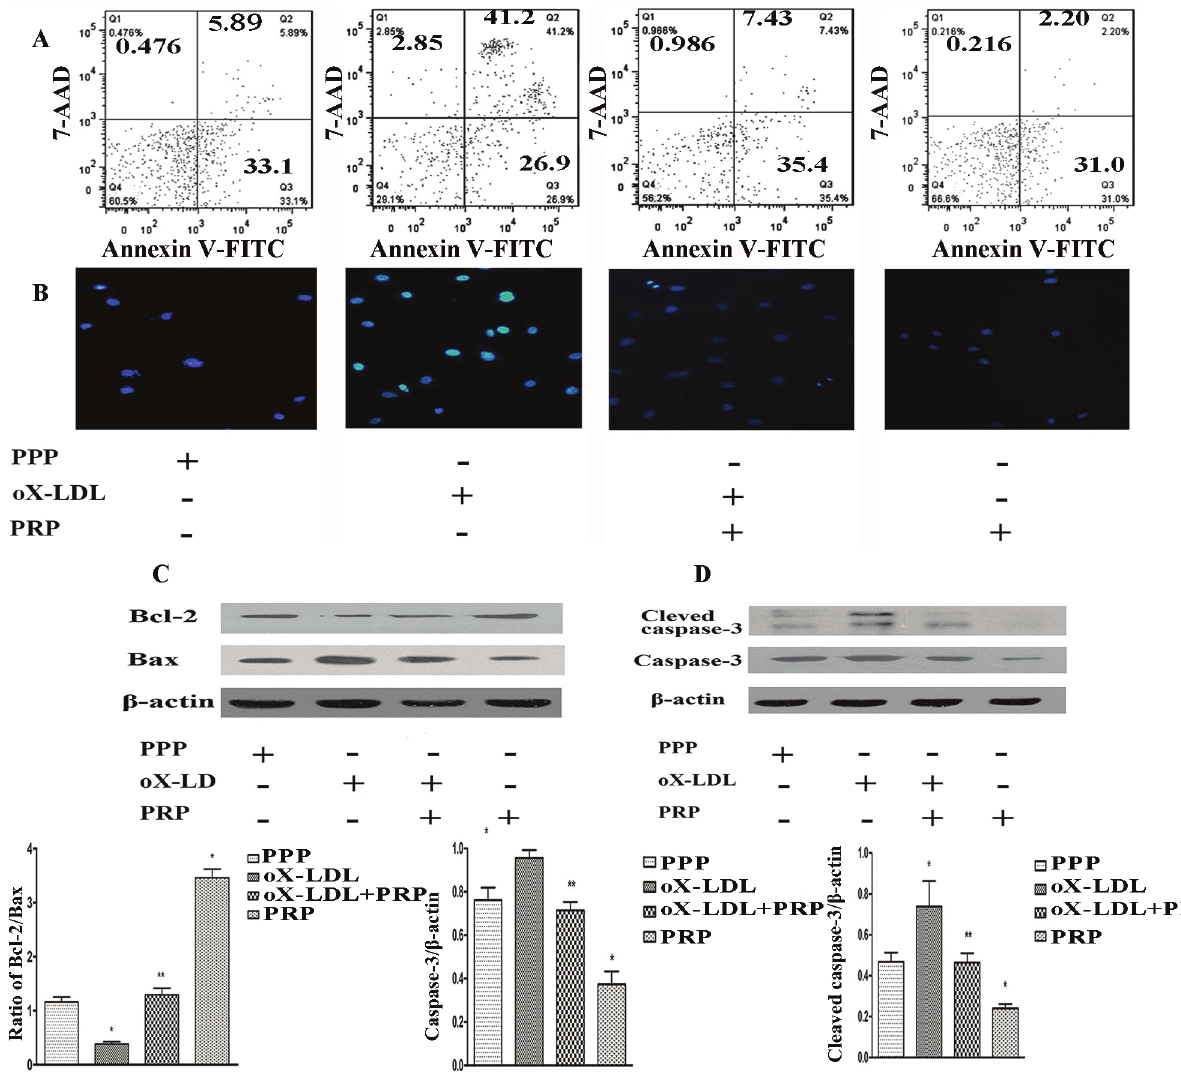
Figure 3: Apoptotic cells and changes in death-related proteins were detected. A: Apoptotic cells were detected by flow cytometry. B: Cells emitting blue fluorescence were stained with Hoechst 33342. C: Bcl-2 and Bax were detected by western blotting. D: Cleaved caspase-3 and caspase-3 were detected by western blotting. *p<0.05 versus control; **p<0.05 versus